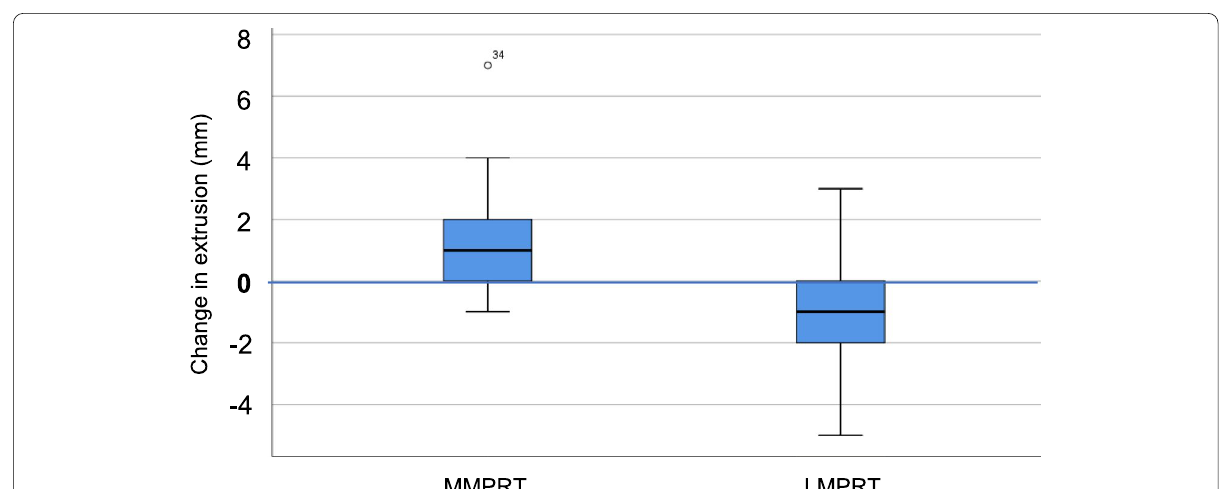
Fig. 3 Change in meniscal extrusion (mm) from pre-to postoperatively for the LMPRTs (lateral meniscus posterior root tears) and MMPRT (medial meniscus posterior root tears)